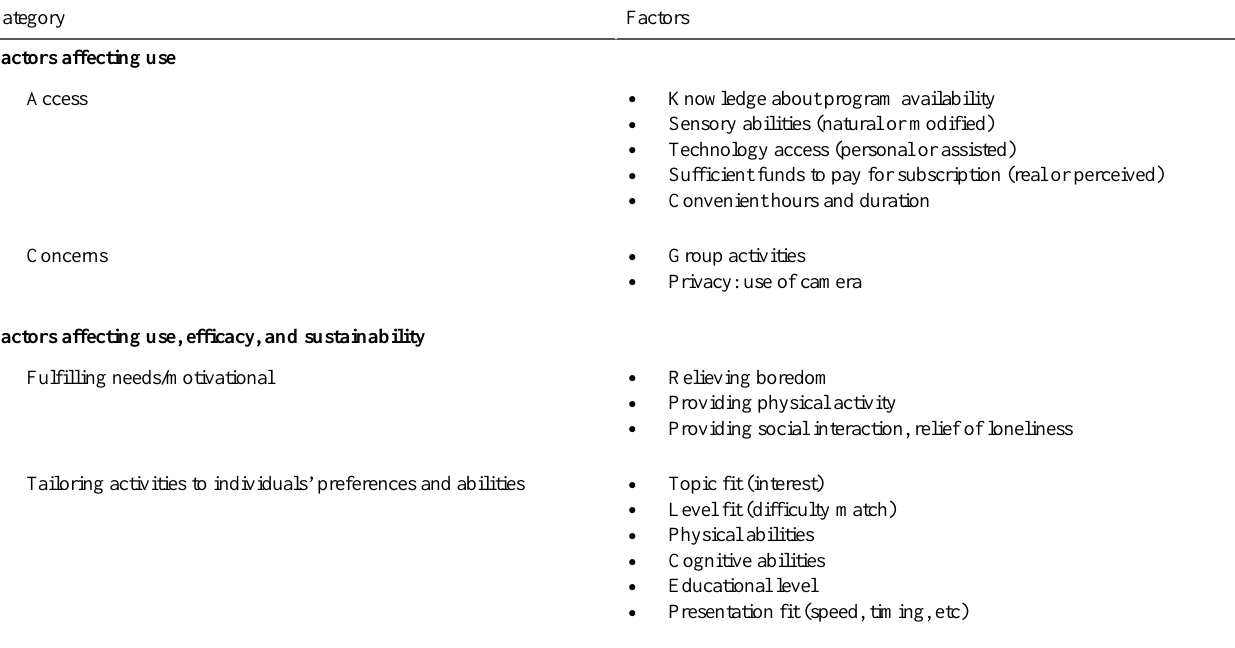
Table 6. Conceptual model: Factors affecting the use, efficacy, and sustainability of web-based activities.